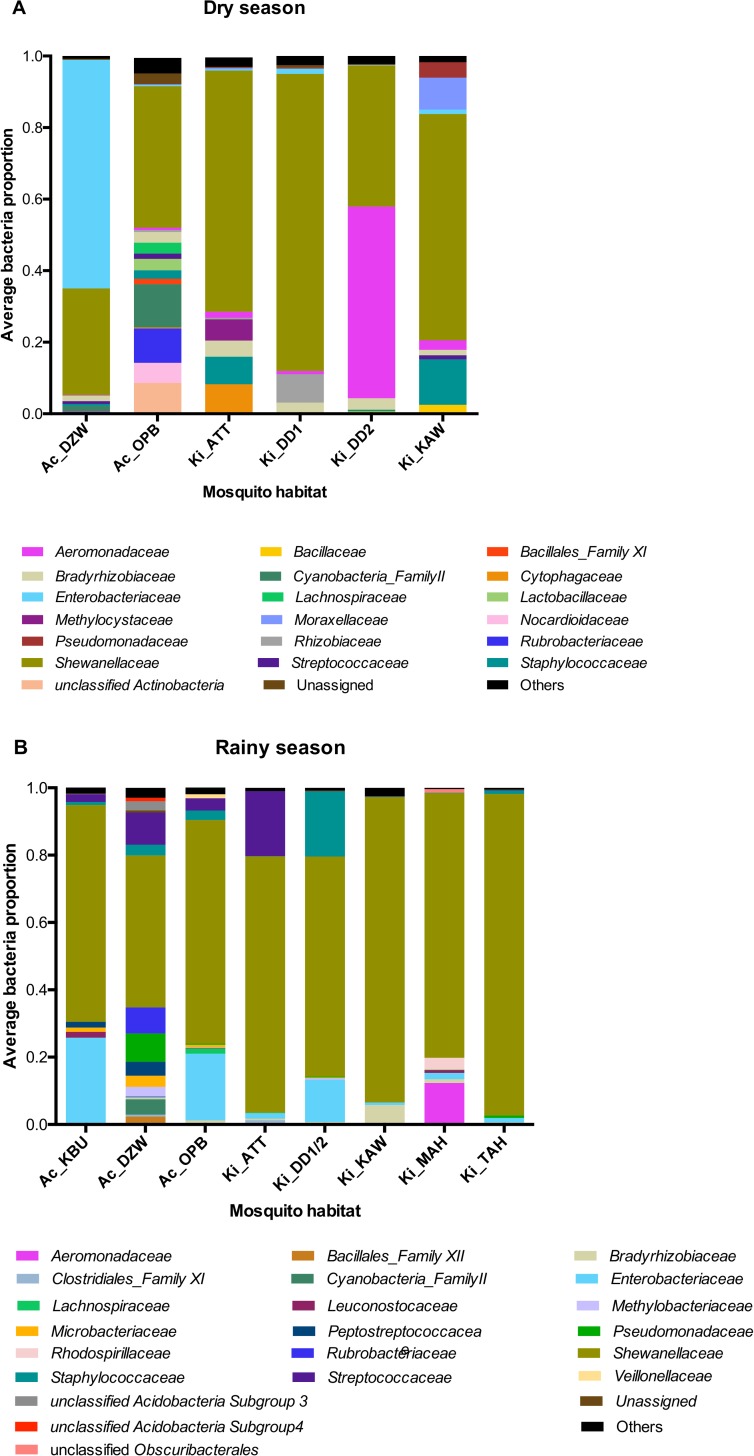
Bacterial family proportions in mosquito midguts sampled from breeding sites in Accra Metropolis (Ac_KBU, Ac_DZW, Ac_OPB) and Kintampo North Municipality (Ki_ATT, Ki_DD1, Ki_DD2, Ki_DD1/2, Ki_KAW, Ki_MAH, Ki_TAH) during the dry (A) and rainy (B) seasons. Families representing ≥0.01 proportions in each site are shown; all families <0.01 are grouped as ‘Others’.